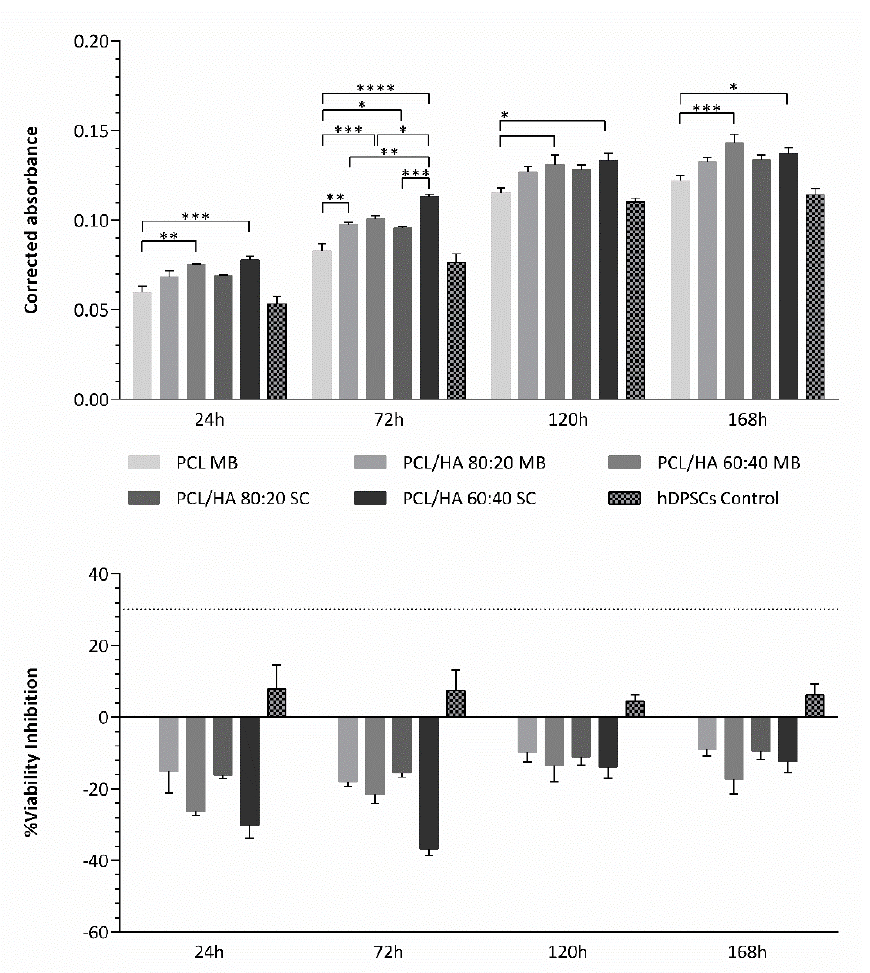
Figure 8. Cytocompatibility assessed by Presto Blue TM viability assay for hDPSCs. The results are presented in mean ± SE. Differences were considered statistically significant at p ≤ 0.05. Results’ significance is presented through the symbol (*), according to the p value, with one, two, three or four symbols, corresponding to 0.01 < p ≤ 0.05; 0.001 < p 0.01; 0.0001 < p ≤ 0.001 and p ≤ 0.0001, respectively. Table 4. Cytocompatibility assessed by Presto Blue TM viability assay for hDPSCs. Corrected absorbance results are presented in mean ± SE.